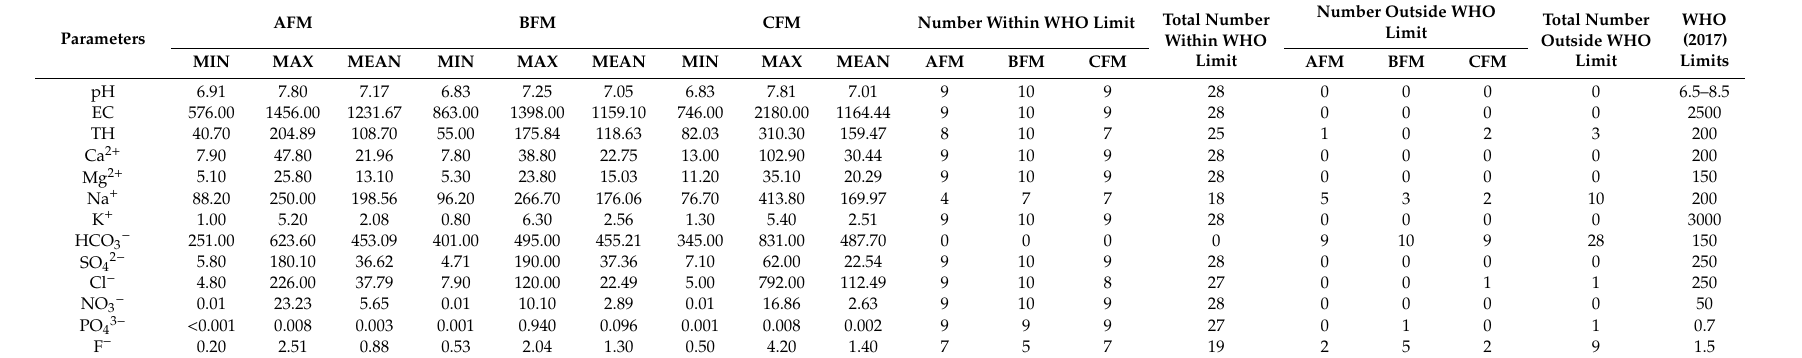
Table 4. Descriptive statistical summary of hydrochemical parameters within the three geological units of the study